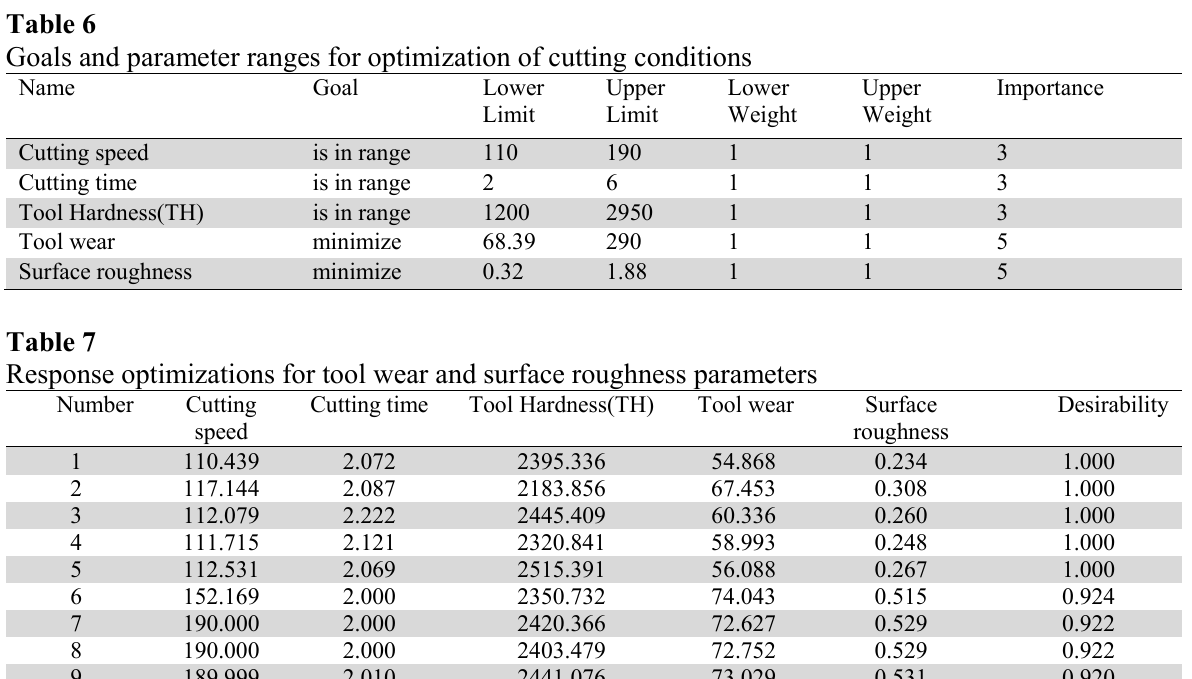
Fig. 8. Effect of cutting time and tool hardness on surface roughness